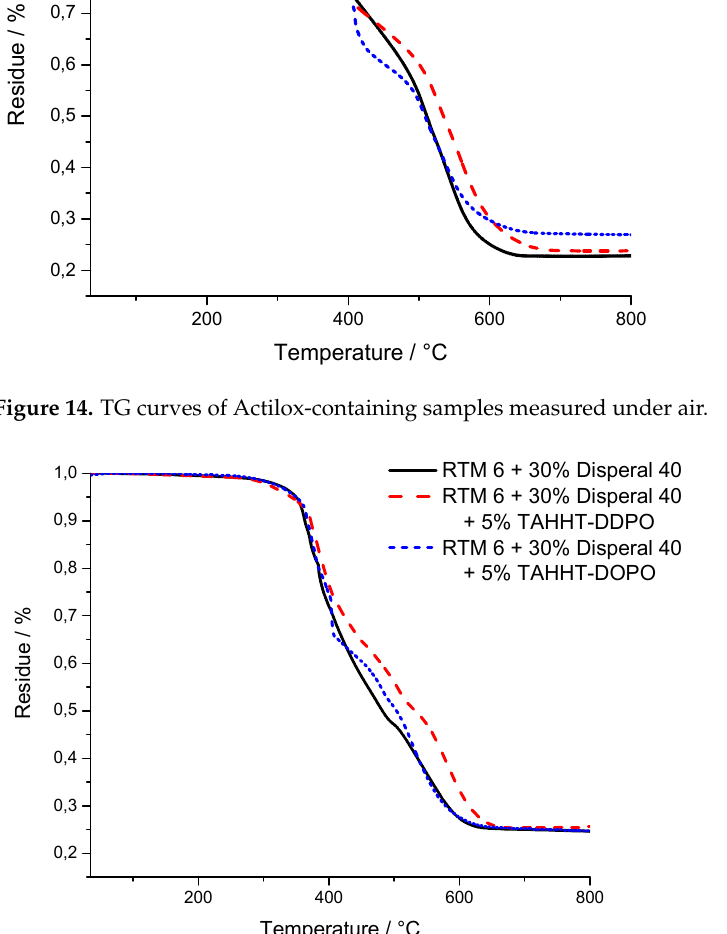
Figure 15. TG curves of Disperal-containing samples measured under air.